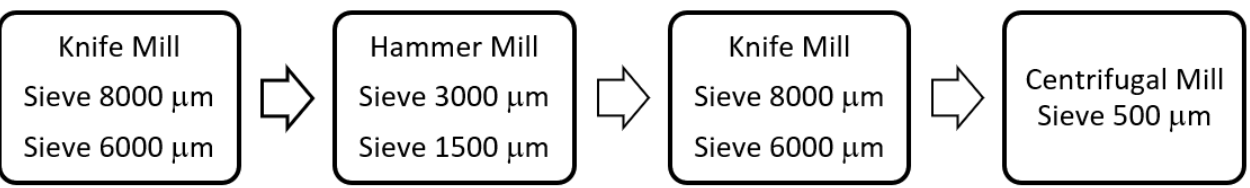
Figure 1. Schematic representation of carob milling process.